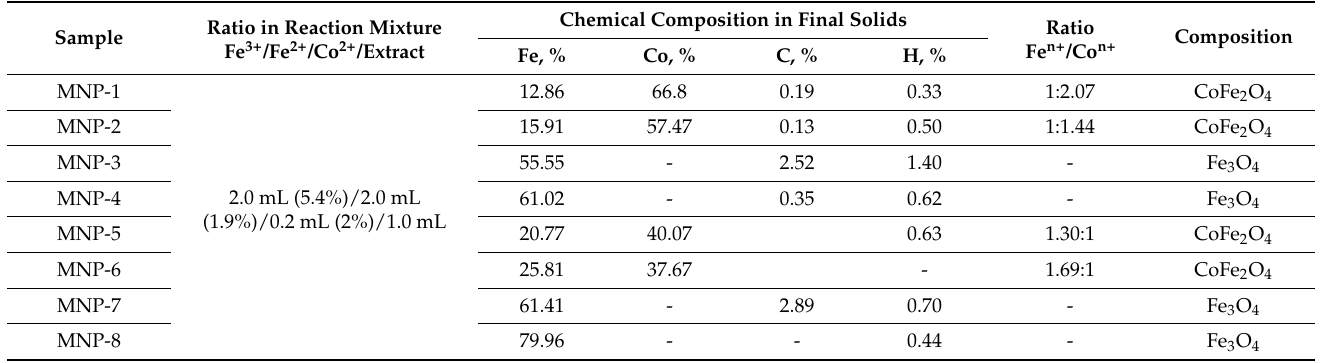
Table 2. Synthesis conditions and chemical composition in the resulting